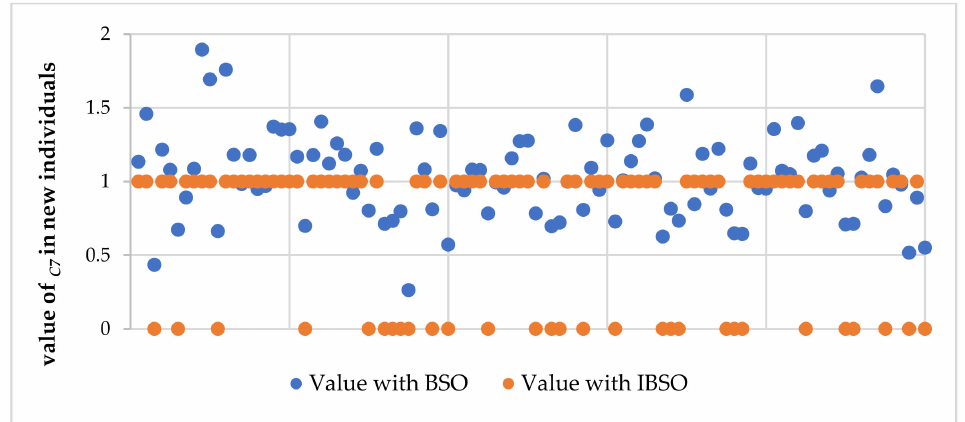
Figure 8. The values of C7 in new individuals with BSO and